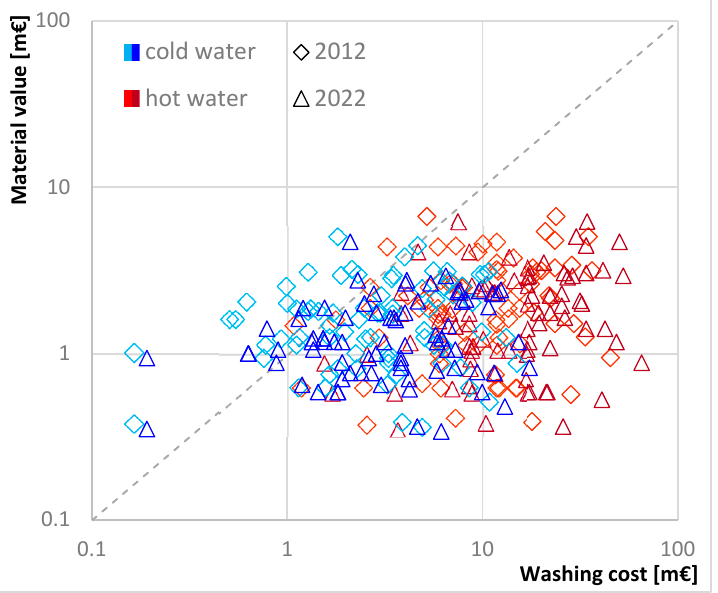
Figure 3. Comparison of the value of recyclable material and the cleaning cost for plastic packaging.